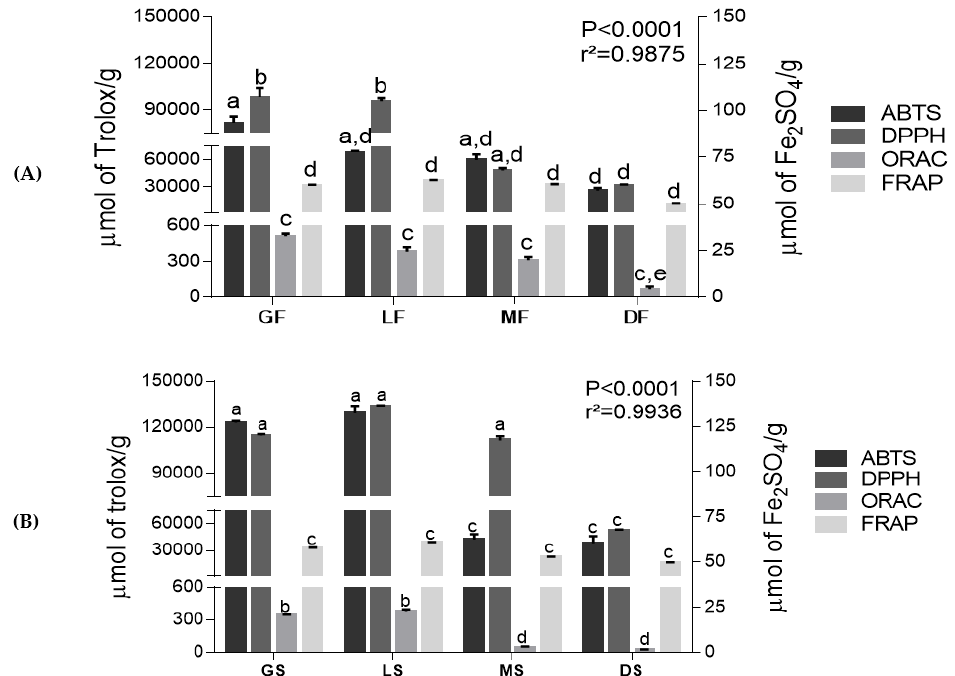
Figure 1. Antioxidant activity potential according to DPPH assay, Trolox Equivalent Antioxidant Capacity (ABTS/TEAC), Ferric Reducing Ability (FRAP) and Oxygen radical absorbance capacity (ORAC) analyses of freeze-dried ( A ) and spray-dried ( B ) coffee extracts. Different letters in the same analysis mean that samples are different ( p < 0.05) and same letters indicate the samples are the same ( p > 0.05). Abbreviations: GF—green freeze-dried, LF—light roasted freeze-dried, MF—medium